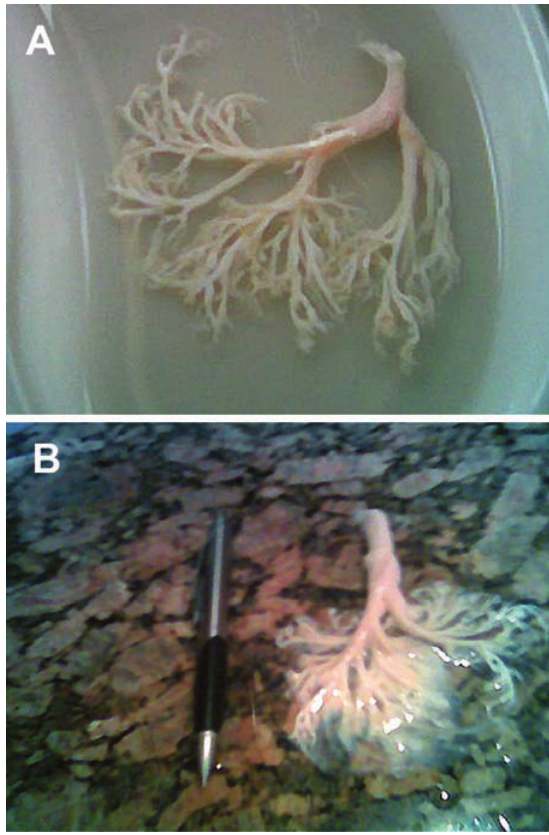
Figure 1 - Expectoration by the patient on two distinct occasions. Note the aspect that mimics a bronchial segment cast (A) and the mucoid character- istics of the material